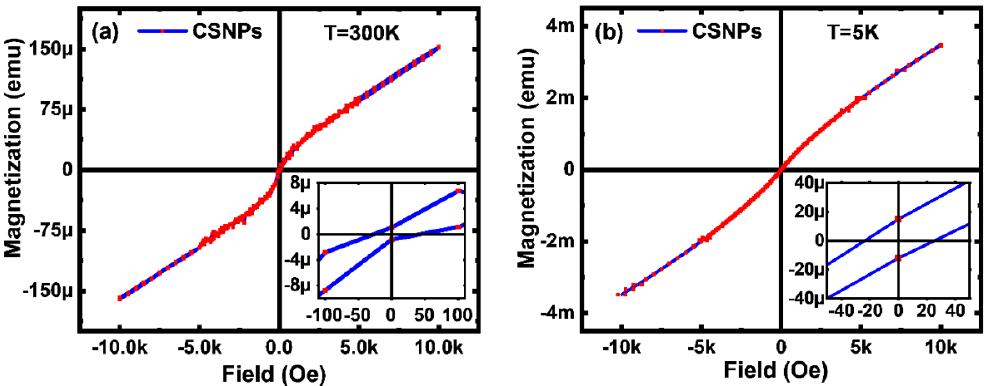
Figure 6. Field dependence of magnetization for the CSNP at ( a ) 300 K and ( b ) 5 K. Inset in the figure shows the low field fragment of the hysteresis loop. Scaling of the vertical axis is different (micro vs. milli) in ( a ) and ( b ).